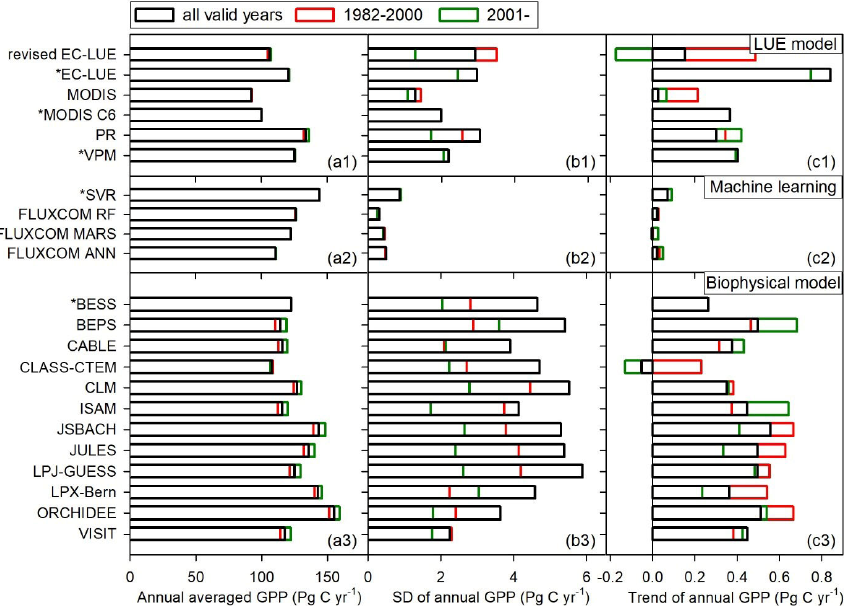
Figure 11. Comparison of (a1) – (a3) averaged annual GPP, (b1) – (b3) interannual variability in annual GPP represented by standard deviation (SD), and (c1) – (c3) annual GPP trend among different GPP datasets or models. The references of these models are the same as in Fig. 9. The asterisk indicates that the valid period of the dataset begins from 2000 or